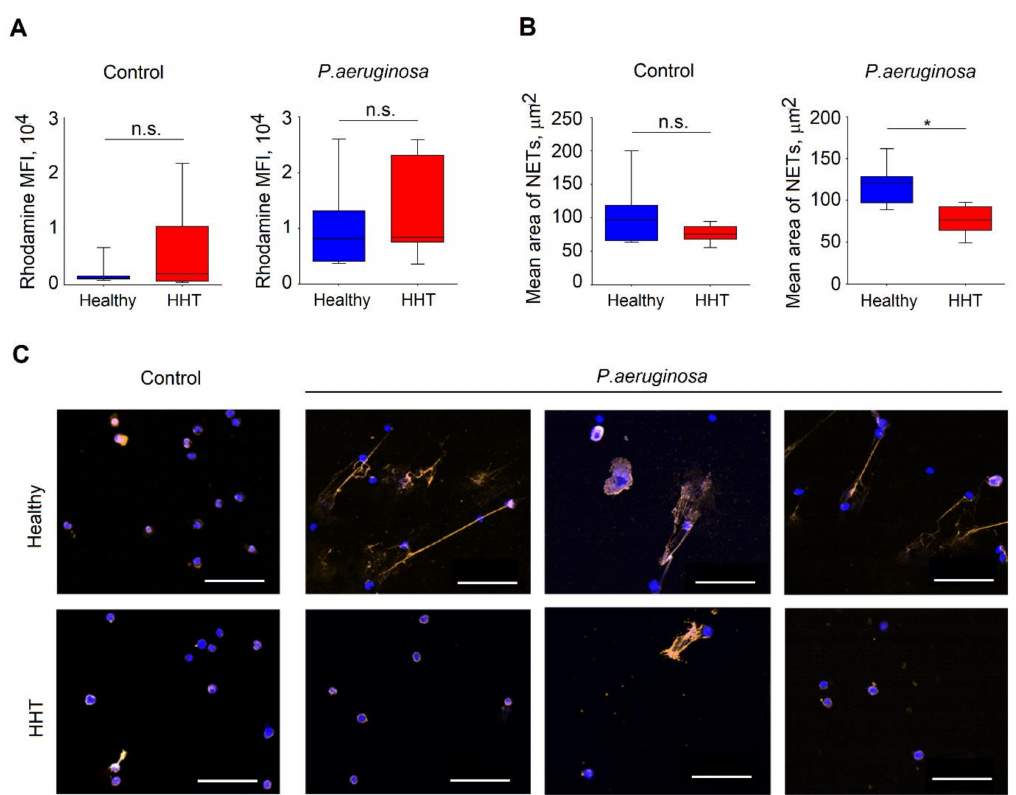
Figure 4. ROS and NET production in patients with HHT compared to healthy individuals. ( A ) ROS were detected in polymorphonuclear leucocytes (PMNs) of HHT patients and healthy individuals after challenge with P. aeruginosa and in control; no difference was observed. ( B ) Decreased mean area per one neutrophil covered with NETs in HHT in the presence of P. aeruginosa. Data are presented as median (25–75 percentiles); Mann–Whitney U test was used to compare groups, * p < 0.05. ( C ) Representative pictures illustrating the decreased NET formation in HHT. Histone 1 in orange, DAPI in blue, scale bar: 50 µ m. Healthy: n = 7, HHT: n = 9. HHT = hereditary hemorrhagic telangiectasia, MFI = mean fluorescence intensity, ROS = reactive oxygen species, NETs = neutrophil extracellular traps, P. aeruginosa = Pseudomonas aeruginosa , 4 (cid:48) ,6-diamidin-2-phenylindol = DAPI, h = hours, n = number of